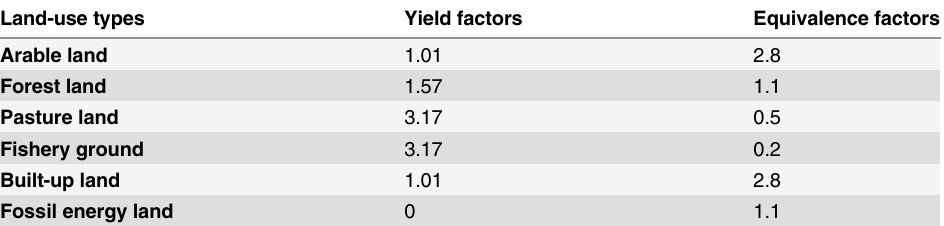
Table 1. The values of yield factors and equivalence factors of different land-use types [27 –